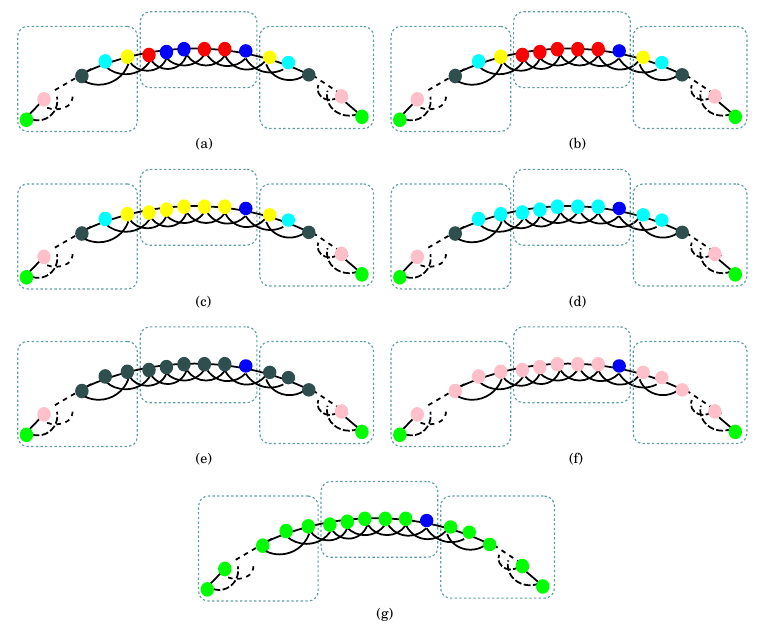
Fig. 7: A sequence of moves to flood the arms of the gadget presented in Figure 4( b )